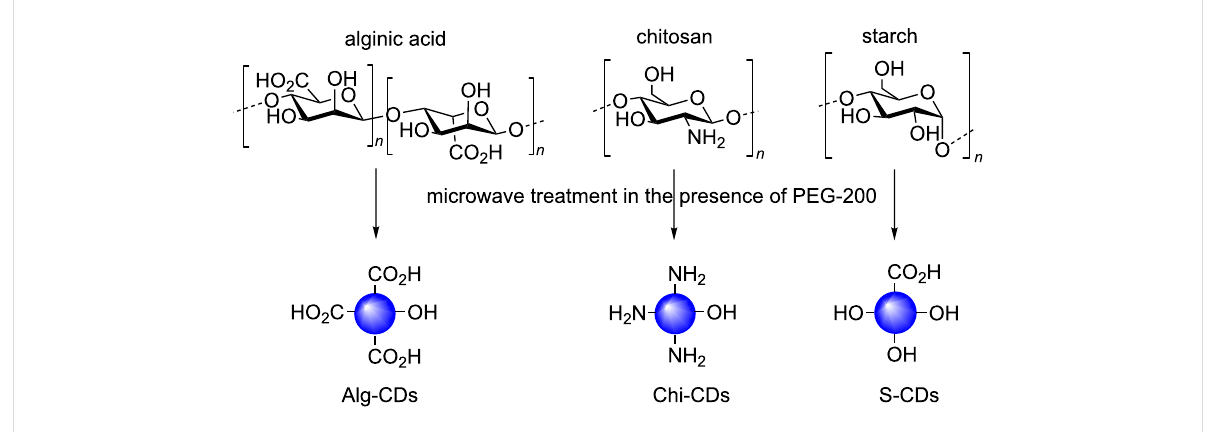
Scheme 20: Different polysaccharide-derived CDs in the presence of PEG-200 and how the starting material composition is conferred to the CD